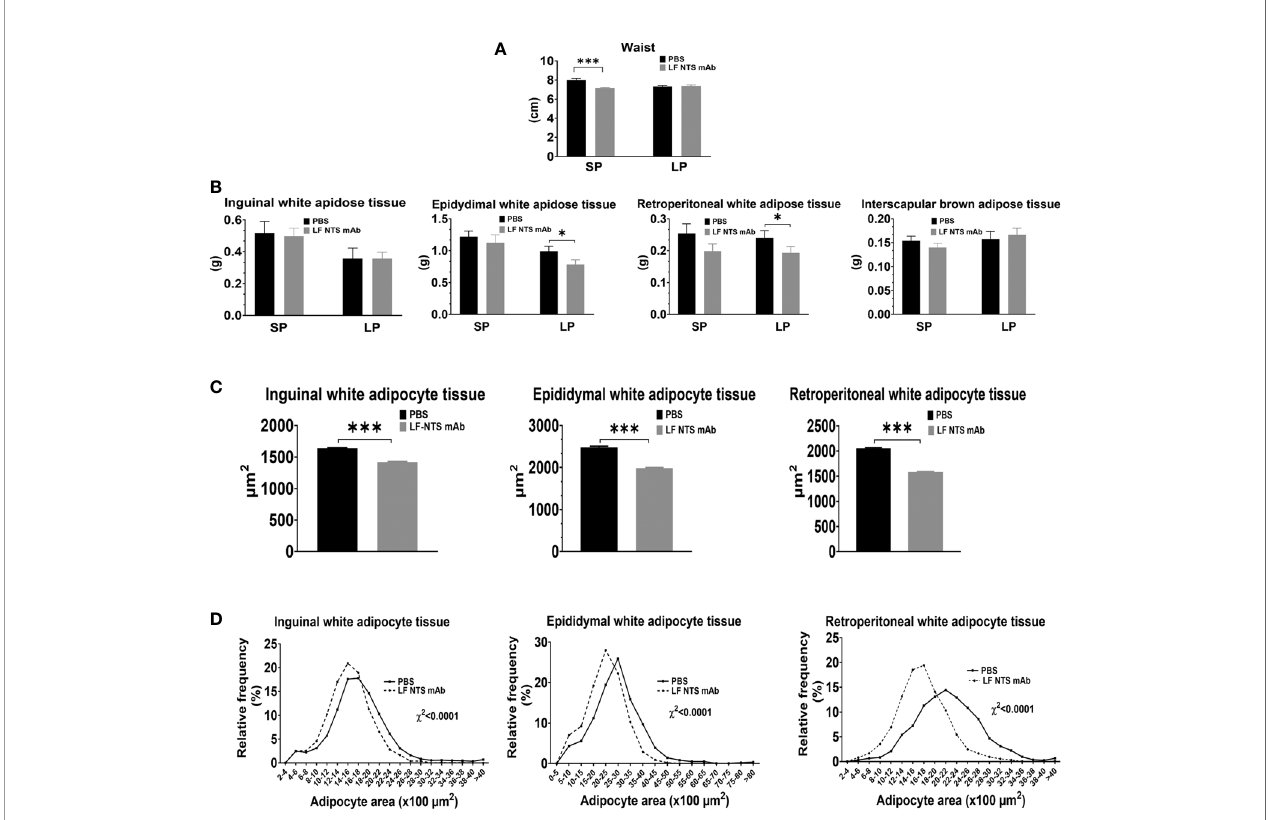
FIGURE 4 | Adipocyte tissue analysis. (A) Waist size of dead mice at the dissection (n = 10), Adipose tissues was collected and weight immediately at the dissection. (B) weight of inguinal (n = 10), epididymal (SP n = 10 LP n = 18), retroperitoneal white adipose tissues (n = 10), and interscapular brown adipose tissue (SP n = 10 LP n = 18). Size of inguinal epididymal and retroperitoneal adipocytes was evaluated on mice treated by LF NTS mAb for SP (n = 10). (C) Mean size of the adipocytes and (D) adipocyte size distribution. t test *p < 0.05; ***p <